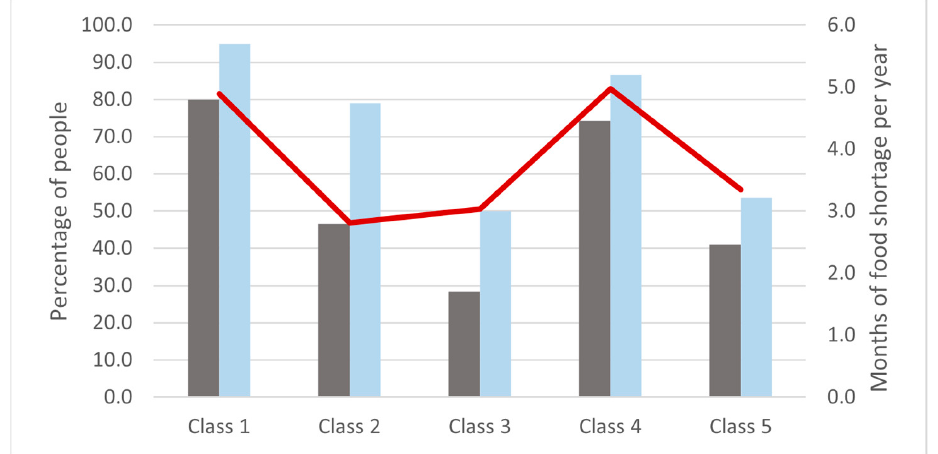
Figure 4. Farmers´ perception about the effectivity of farm-based mitigation measures to reduce crop damage by elephants.